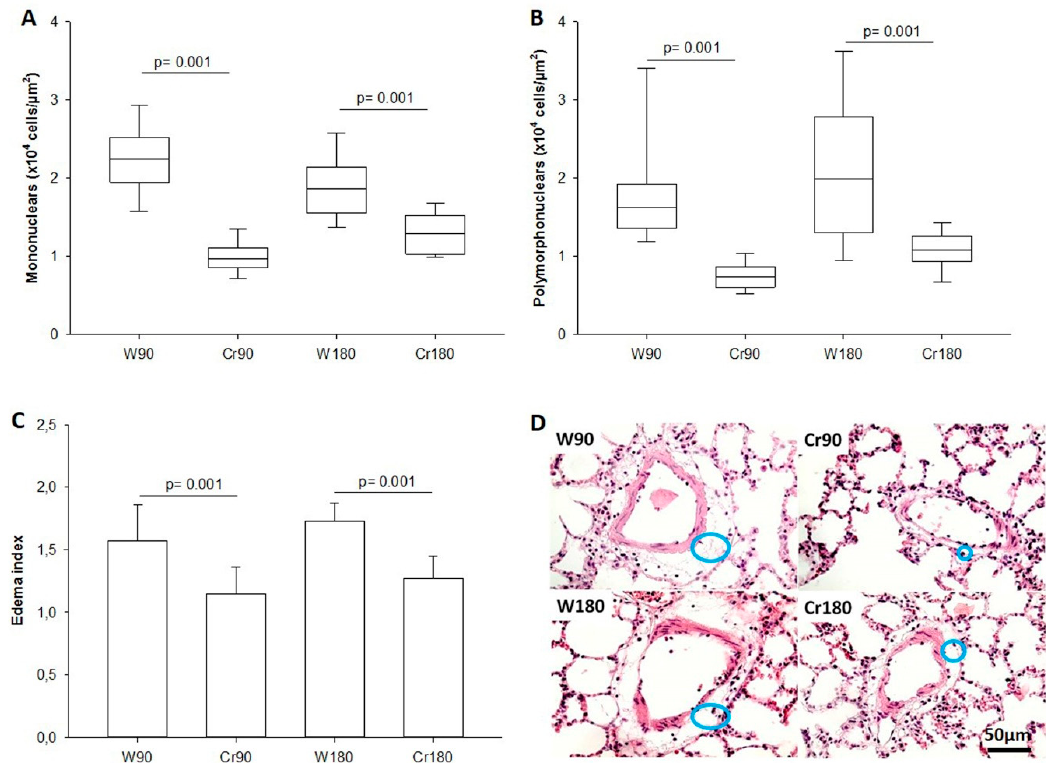
Figure 3. Inflammation and edema index in the lung parenchyma. W90, control/water + 90 min of ischemia; Cr90, creatine + 90 min of ischemia; W180, control/water + 180 min of ischemia; Cr180, creatine + 180 min of ischemia. ( A ) Mononuclear cells; ( B ) polymorphonuclear cells; ( C ) perivascular edema index; ( D ) photomicrographs of the perivascular regions: blue circles show perivascular edema area (H.E., 400×). Data are expressed as median and interquartile range ( A , B ) or mean and standard deviation ( C ) ( n = 8 animals/group).